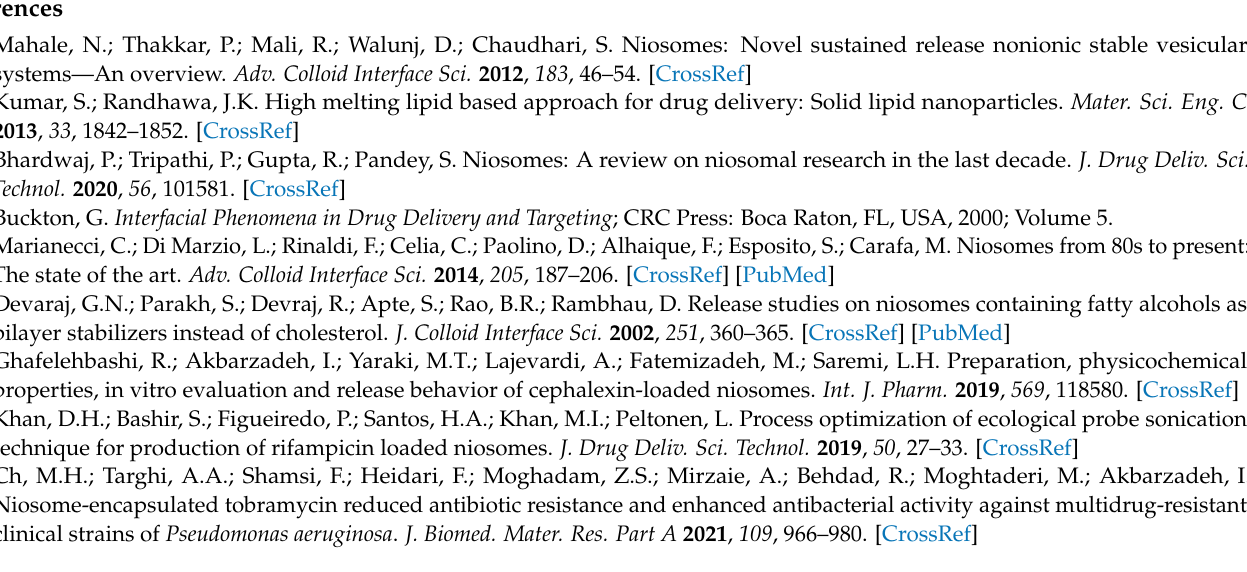
for EE. S: significant; NS: not significant. Table S3: Regression analysis for response size for fitting to the quadratic model. Table S4: Summary of results of regression analysis for responses EE, for fitting to the quadratic model. Table S5: Antibiotic resistance profile among MDR strains of K. pneumoniae . Table S6: The CFU/ml of K. pneumoniae strains after treatment with sub-MIC concentration of free E. angustifolia extract and niosome encapsulated